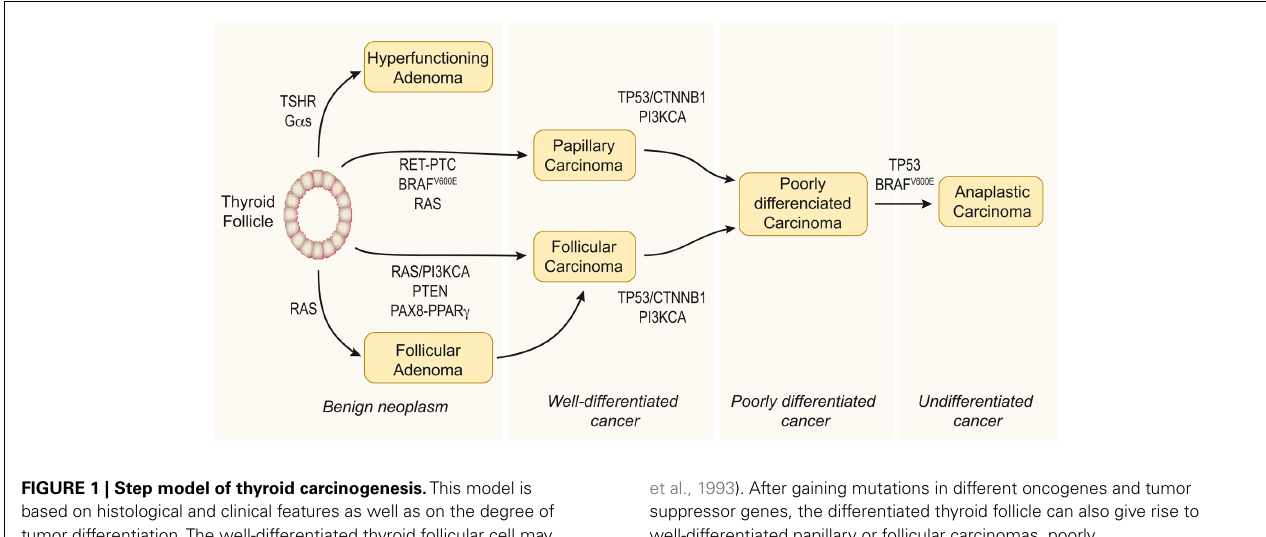
FIGURE 1 | Step model of thyroid carcinogenesis. This model is based on histological and clinical features as well as on the degree of tumor differentiation.The well-differentiated thyroid follicular cell may give rise to both benign and malignant tumors. Autonomously hyperfunctioning thyroid adenomas are associated with activating mutations in the TSHR or G α s genes (O’Sullivan et al., 1991; Parma